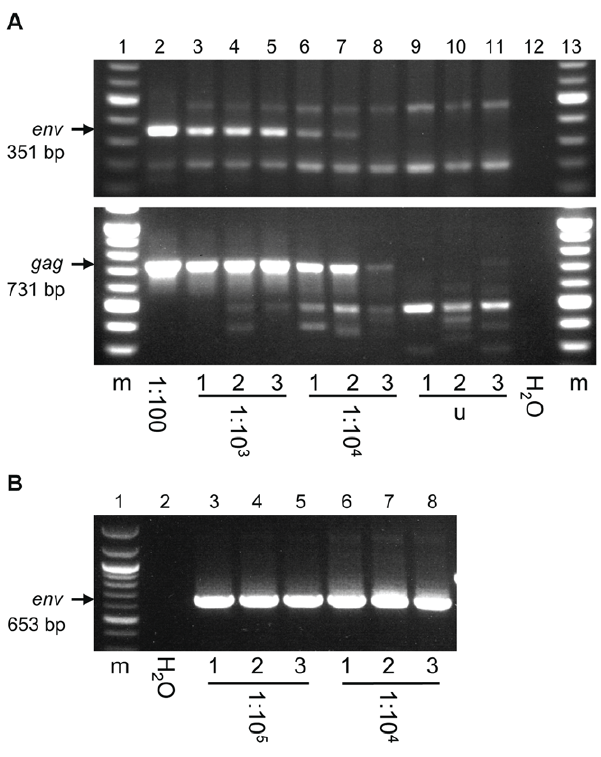
Figure 1. Sensitivity analysis of XMRV PCR assays. PCR products were analyzed on agarose gels containing ethidium bromide. (A) Non- nested PCR assays targeting the XMRV env gene (top panel) and the gag gene (bottom panel), and (B) a nested PCR assay targeting the XMRV env gene were evaluated for their ability to detect either (A) provirus in XMRV-infected PNT1A cell DNA or (B) provirus in XMRV- infected LNCaP cell DNA diluted in uninfected cell DNA. Dilutions of infected cells in uninfected cells are indicated by ratios, i.e. 1:10 4 indicates one infected cell diluted in 10 4 uninfected cells. (m) 100 base pair molecular weight marker, (H 2 O) water used in place of DNA template as a negative control, (u) uninfected PNT1A DNA used as template for negative control.